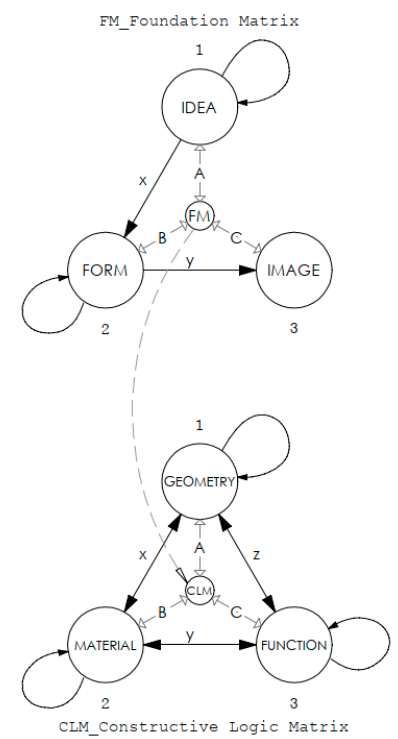
Figure 2. Matrices model and workflow.